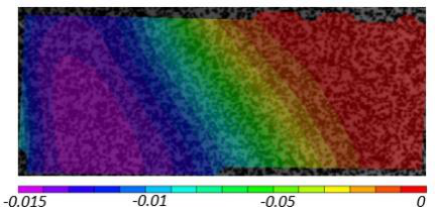
Fig. 7. Strain field of CFRP launched at 113m/s